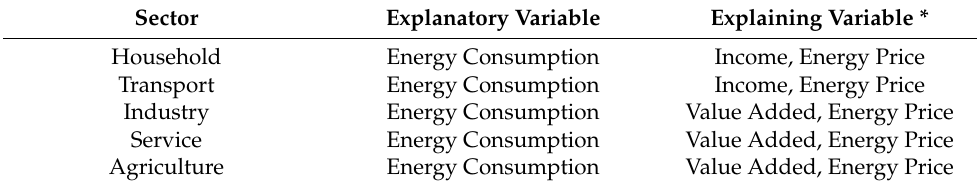
Table 2. Macroeconomic parameters used in the econometric model .